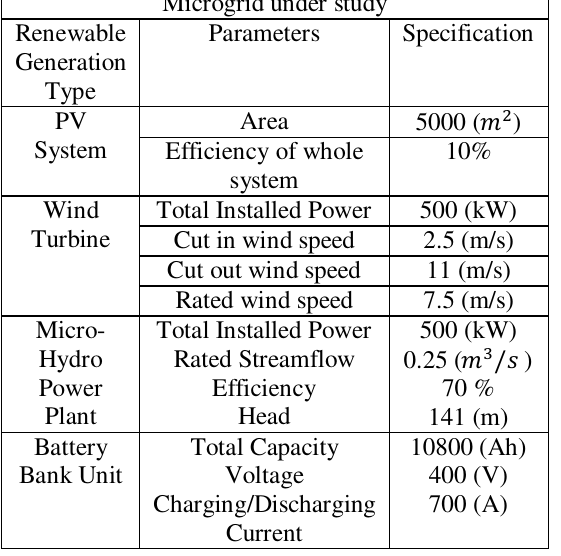
Table 1: Renewable generation specifications